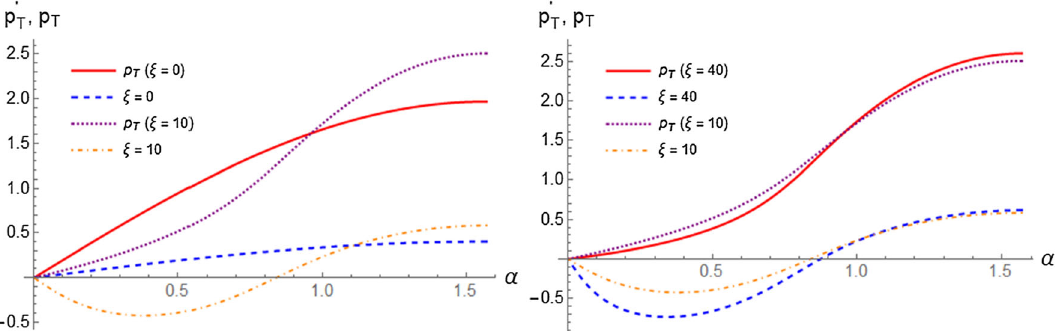
Fig. 13 Left: plots of the anisotropy dependence of the transverse momentum p T (α | ξ) for ξ = 0 (solid), ξ = 10 (dotted) and p (cid:2) ξ = 0 (dashed), ξ = 10 (dashed-dotted). Right: plots of the anisotropy